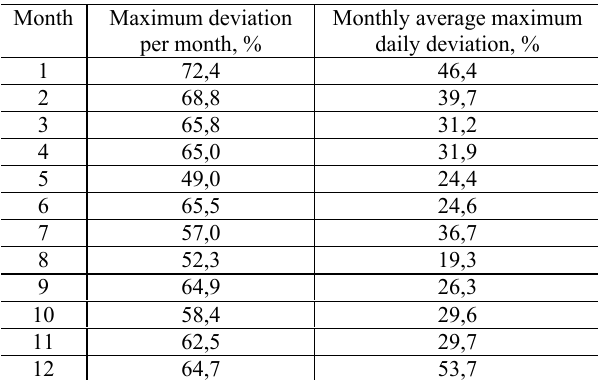
Table 3. Estimates of possible deviations in solar power